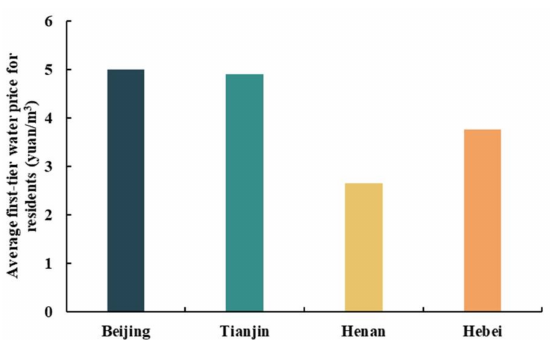
Figure 5. Average first-tier water price for residents of each province of